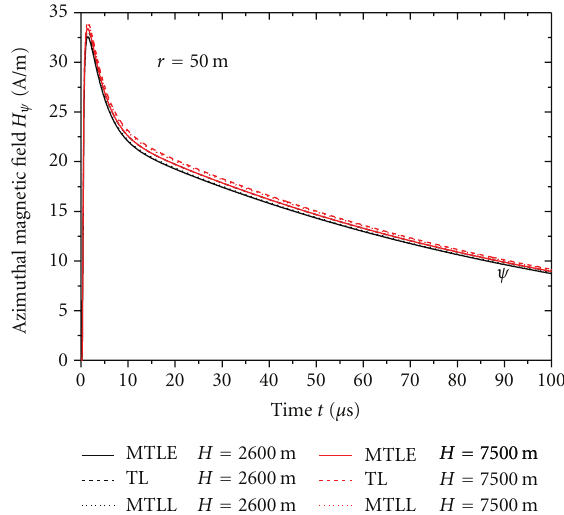
Figure 8: Vertical electric field at 5 km from the channel base for MSS FST, three di ff erent models and two channel heights ( H = 2600 m and 7500 m).